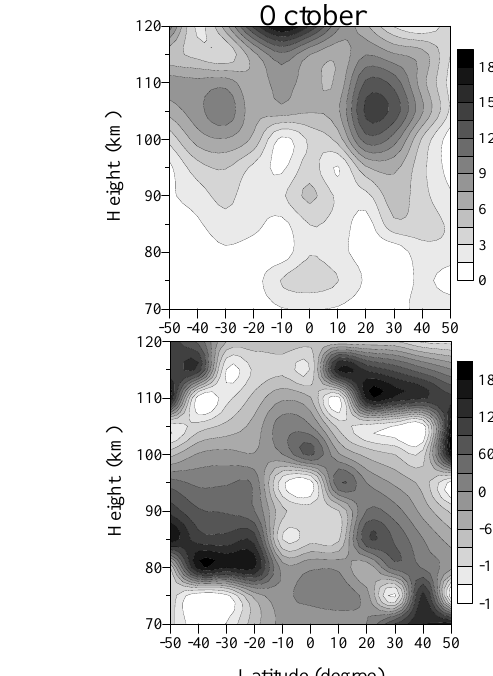
Fig. 10b. The same as Fig. 11a, but for March (left column of plots) and October (right column of